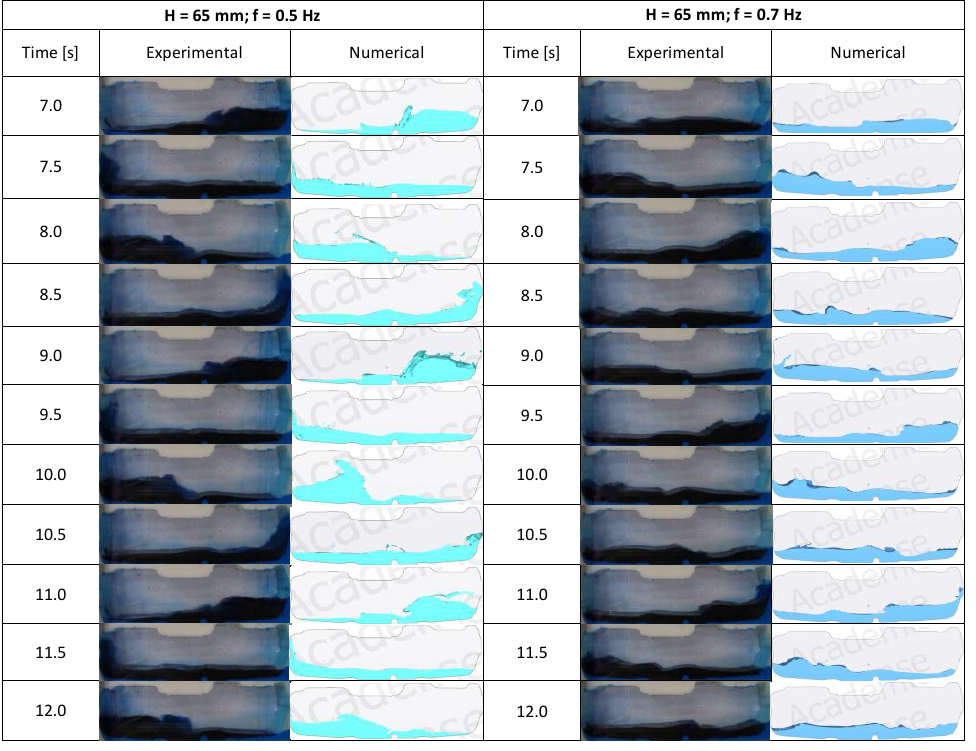
Figure 10. Comparison between numerical and experimental data in the time interval [7 ÷ 12] s for H = 65 mm and frequency of 0.5 Hz and 0.7 Hz.